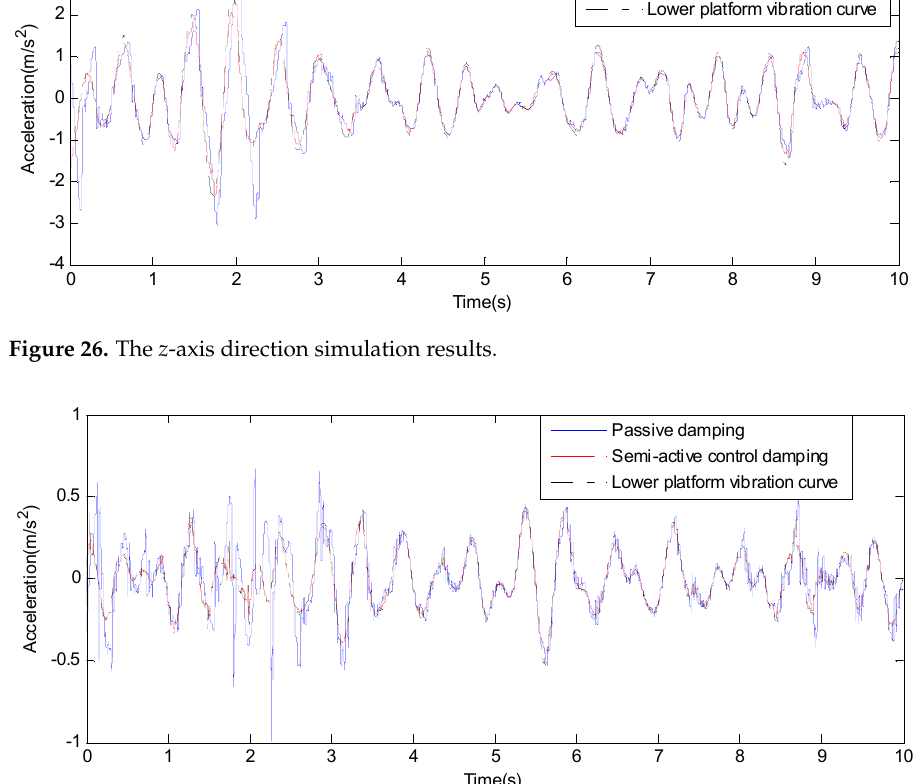
Figure 28. Simulation results of the angular acceleration around the x -axis direction. The blue and red curves in Figures 26–28 show the acceleration results of the upper platform of the damping seat under passive damping and semi-active controlled damp- ing, respectively, in three directions: rotation around the x -axis and translation along the z -axis and y -axis. The black curves in Figures 26–28 show the vibration acceleration signals of the lower platform of the damping seat in the three directions. The root mean square (RMS) values of the simulation results are shown in Table 4. Table 4. Simulation results (RMS value) of the multi-DOF damping seat platform. Direction Condition z -Axis Transla- tion (m/s 2 ) y -Axis Trans- lation (m/s 2 )